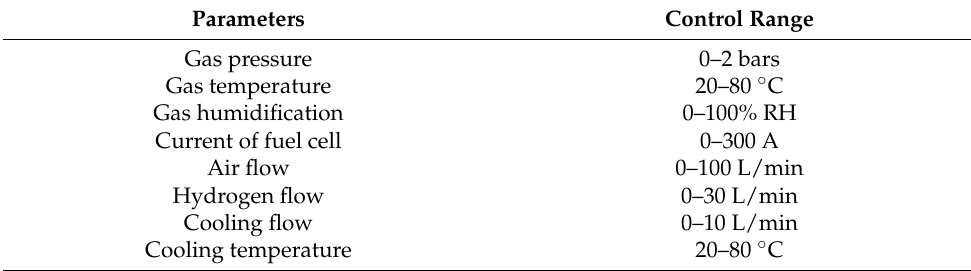
Figure 1. Fuel-cell test bench. Table 1. Range of parameters controlled.